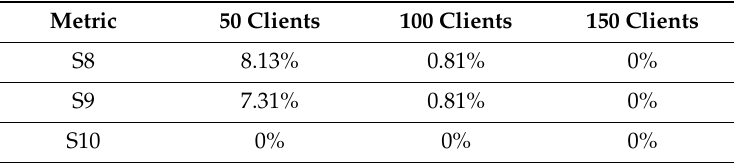
Table 6. False positive rate of MA detection in Scenario 1.